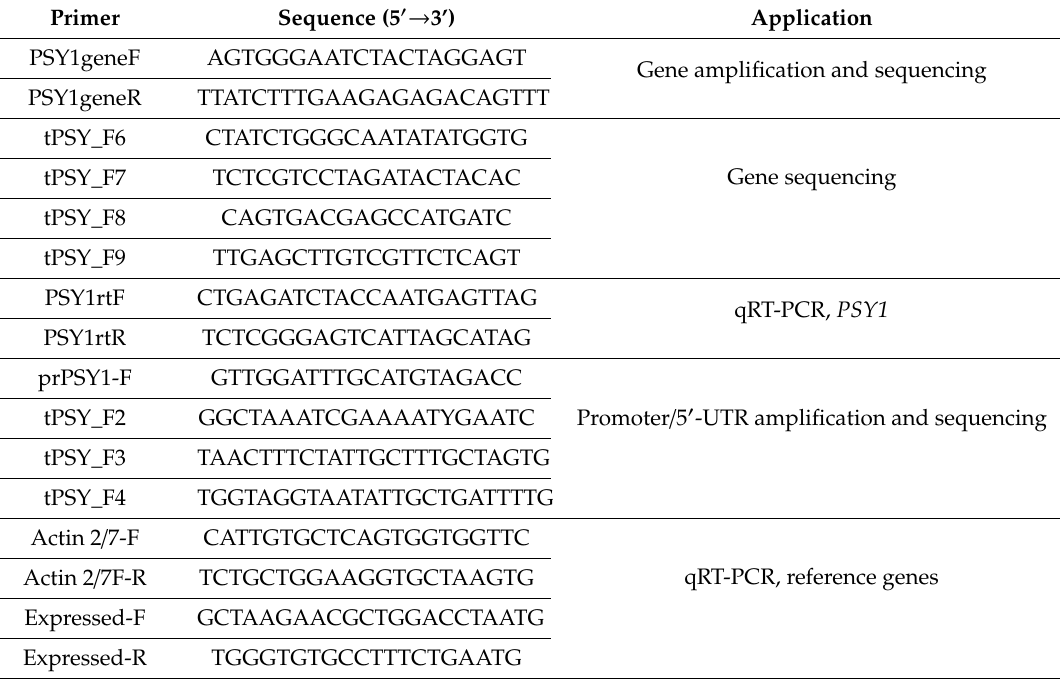
Table 4. List of primers for PSY1 gene amplification, sequencing, and expression